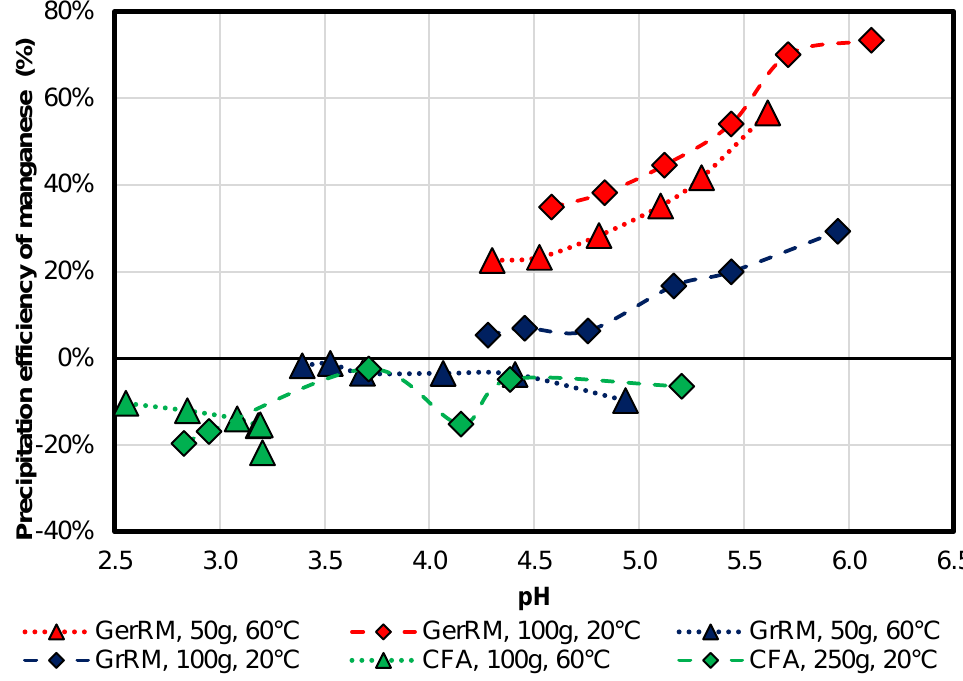
Figure 8. Participation efficiency of manganese.